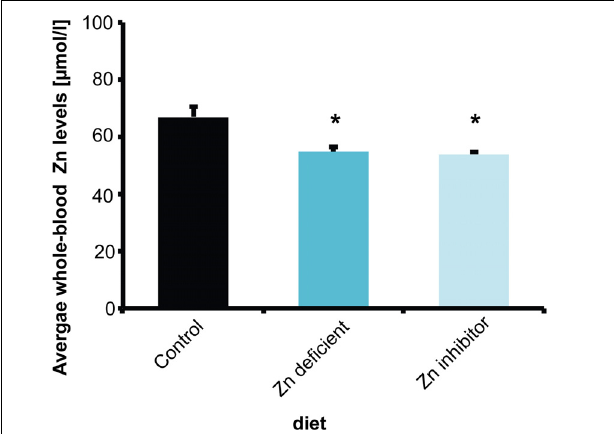
FIGURE 1 | Whole-blood Zn levels of mice measured by AAS in three animals per group. Animals on a control diet (35 ppm) show average zinc levels of 66.7 µ mol/l. After 8 weeks on a zinc-deficient diet ( < 5 ppm), significantly lower zinc levels are measured. Mice on a diet with control zinc levels (35 ppm) but the bioavailability of zinc lowered due to the presence of antagonists of absorption (Zn inhibitor) similarly to mice on a zinc-deficient diet show a significant reduction in whole-blood zinc